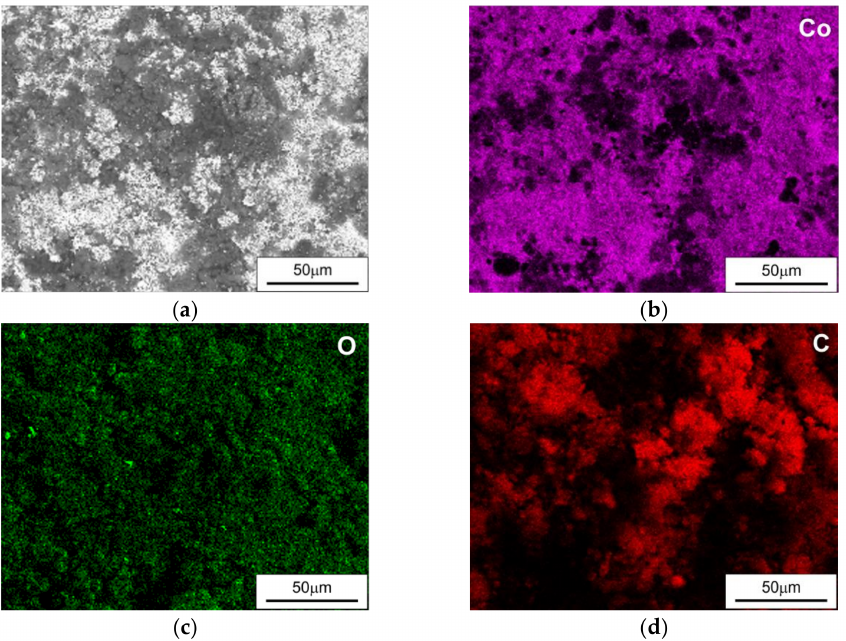
Figure 4. SEM images and EDX mapping analysis of the used catalyst. ( a ) SEM picture of the catalyst surface, ( b ) distribution of deposited cobalt, ( c ) distribution of oxygen, and ( d ) distribution of carbon.